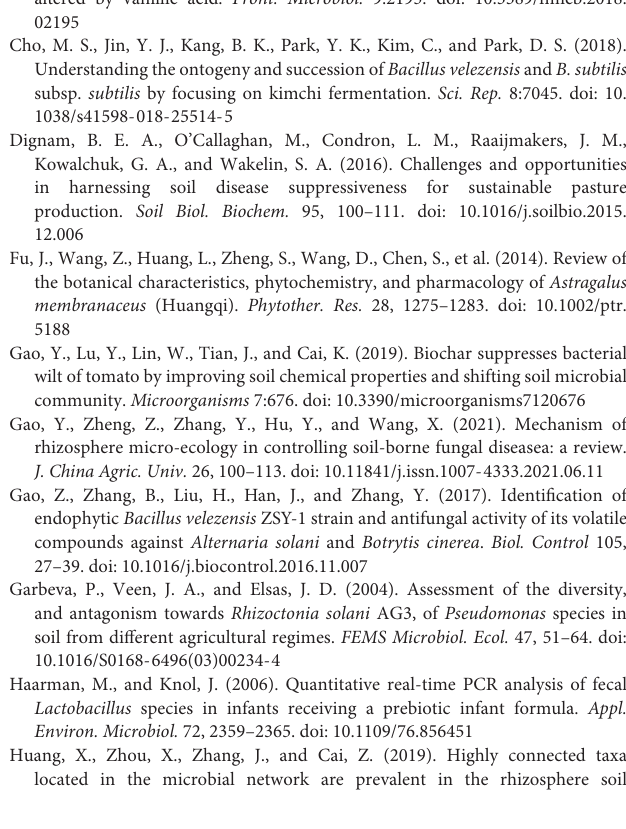
Supplementary Figure 1 | Research roadmap. Supplementary Figure 2 | The half-maximal inhibitory concentration (IC50) of AJ. Supplementary Table 1 | Amplification primers used in this study. Supplementary Table 2 | Processed sample data information to analyze bacterial and fungal community of AJ. Supplementary Table 3 | Alpha diversity of bacterial and fungal community of AJ. Supplementary Table 4 | The relative abundance of top 10 bacterial and fungal genus. Supplementary Table 5 | Volatile organic compounds (VOCs) of